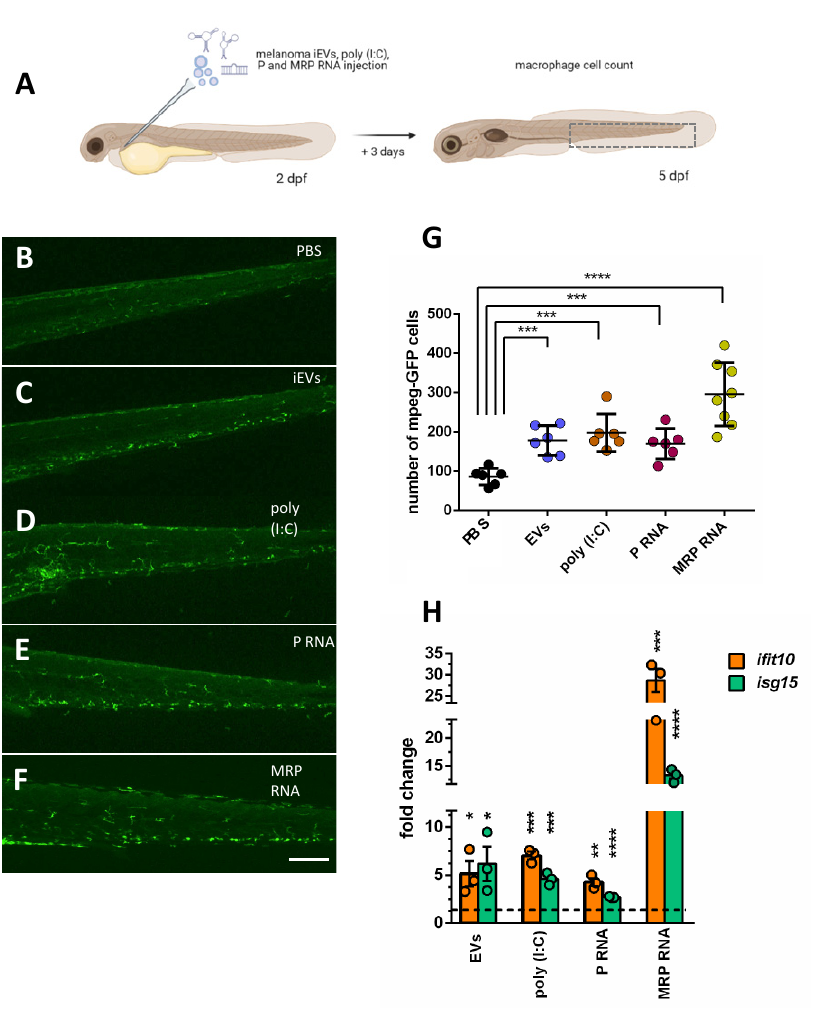
Figure 6. Injection of MRP or P RNA in larvae increases mpeg+ cells and IRG expression, similar to poly-I:C and iEVs. ( A ) Schematic representation of the experimental procedure for intravascular injection of melanoma iEVs, poly (I:C) and RNA, and inflammatory cell counts (drawing realized with BioRender). ( B – F ). Representative images of the CHT regions of 5 dpf tg(mpeg:GFP) gl222 larvae injected with the indicated molecules. ( G )). Counts of macrophages in the CHT of injected larvae. ( H ) QPCR analysis of the expression of two interferon-responsive genes, ifit10 and isg15 , in larvae injected with the indicated molecules, compared to PBS-injected (horizontal dashed line). * p < 0.05; ** p < 0.01; *** p < 0.005; **** p < 0.001. Scale bars: 100 µ